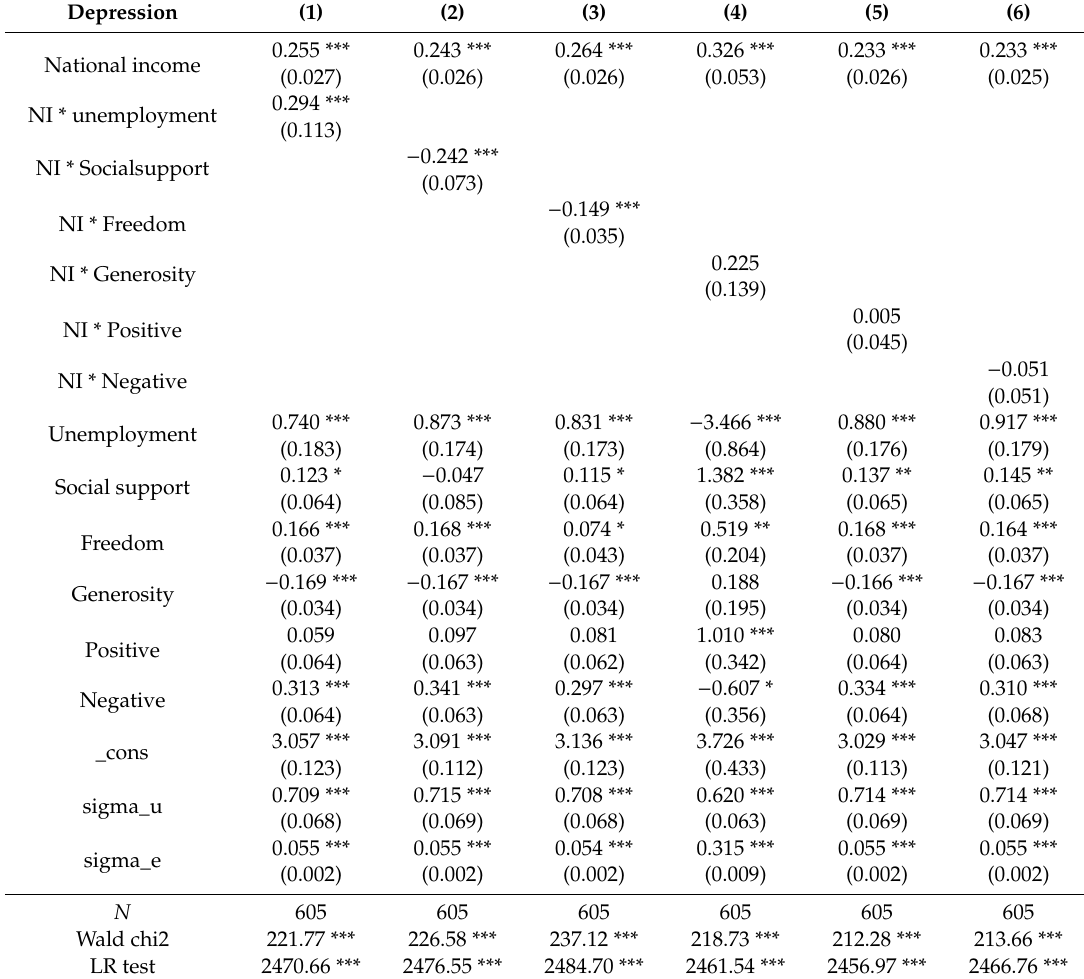
Table 9. The moderating e ff ect between national income and depression.